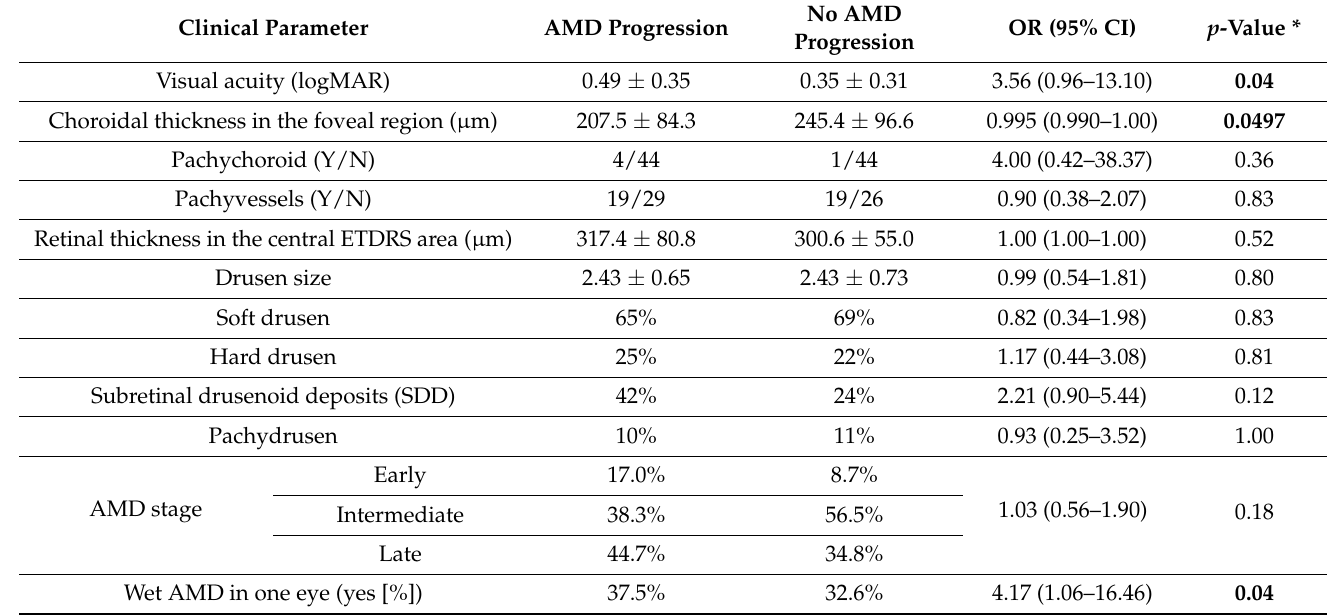
Table 2. State of disease progression with regard to the baseline clinical characteristics of the study subjects. The data are presented as the mean ± SD.